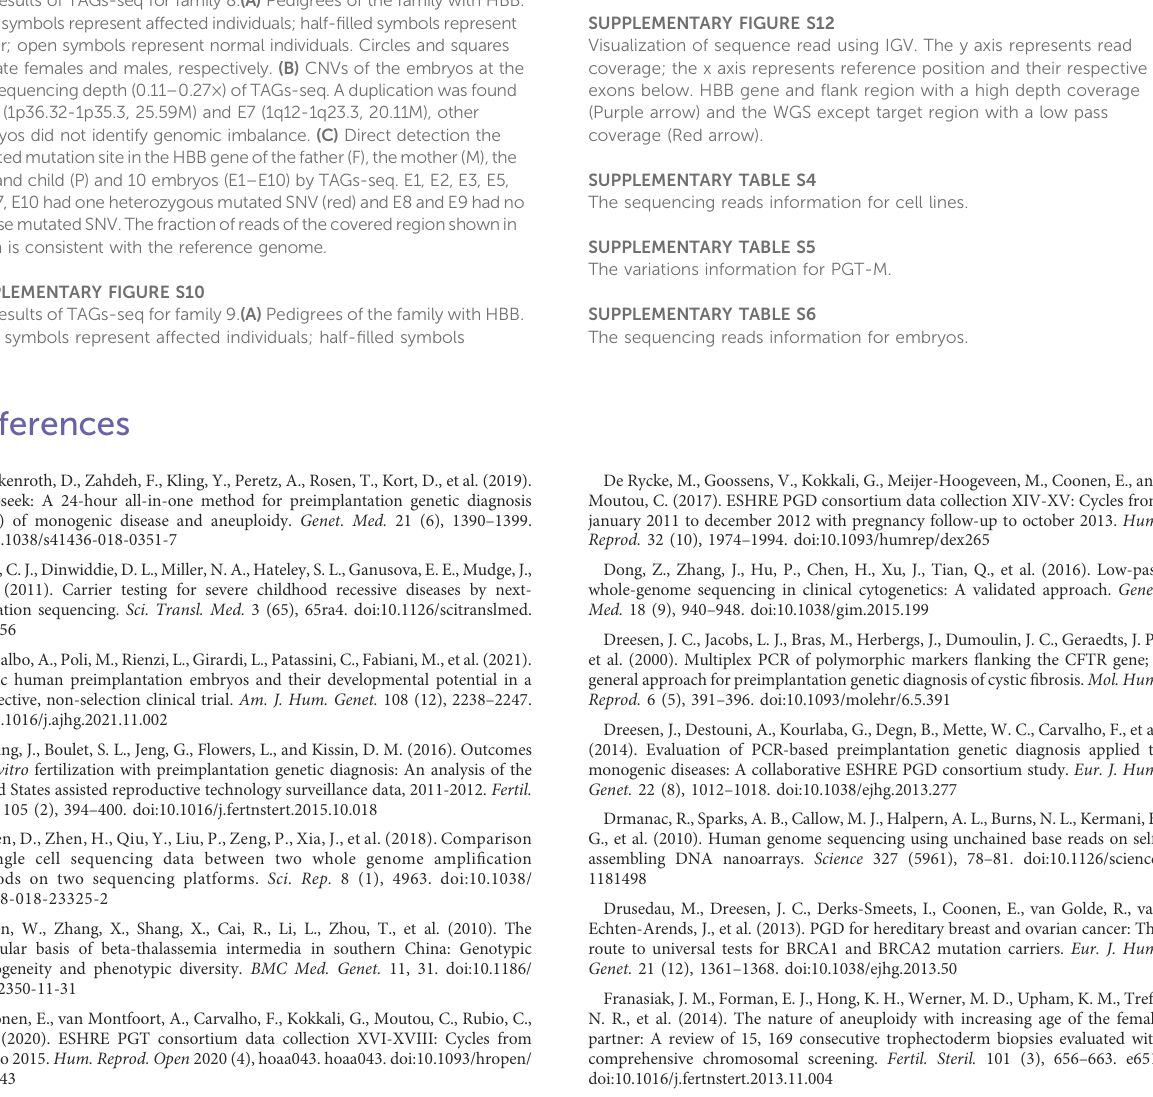
SUPPLEMENTARY FIGURE S12 Visualization of sequence read using IGV. The y axis represents read coverage; the x axis represents reference position and their respective exons below. HBB gene and fl ank region with a high depth coverage (Purple arrow) and the WGS except target region with a low pass coverage (Red arrow). SUPPLEMENTARY TABLE S4 The sequencing reads information for cell lines. SUPPLEMENTARY TABLE S5 The variations information for PGT-M. SUPPLEMENTARY TABLE S6 The sequencing reads information for